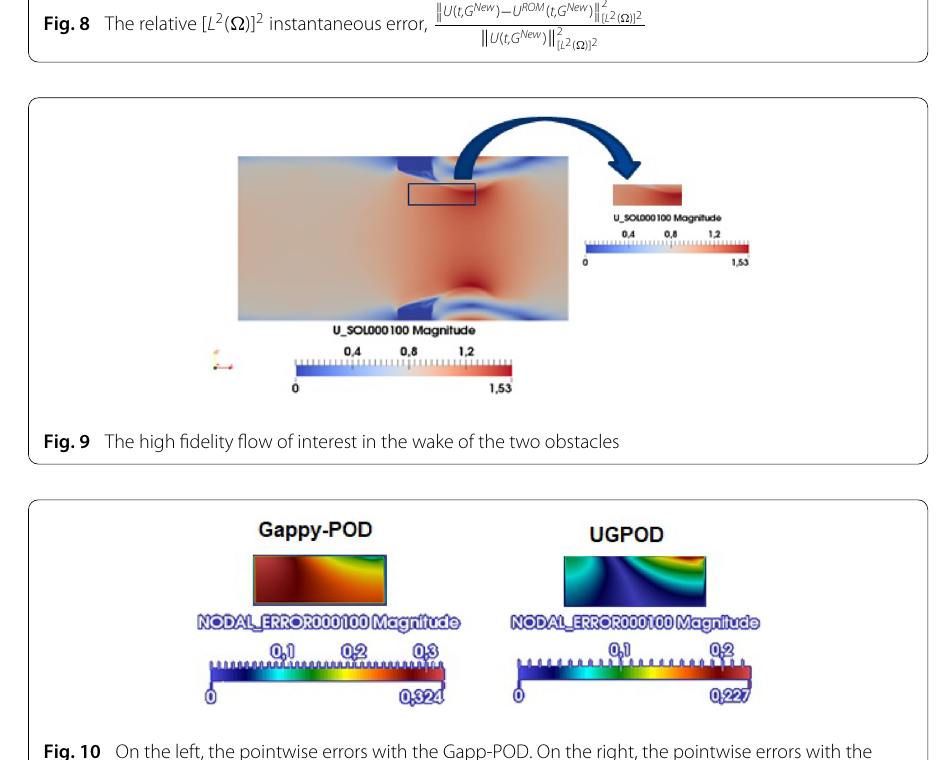
(cid:7) (cid:7) U ( t,G New ) − U ROM ( t,G New ) (cid:2)